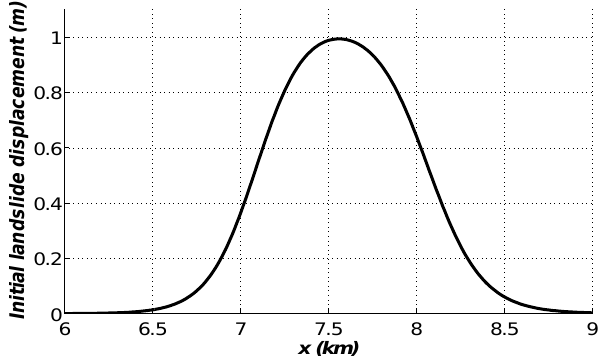
Fig. 4. Initial landslide shape (24) along the bottom profile h ∼ x 4 / 3